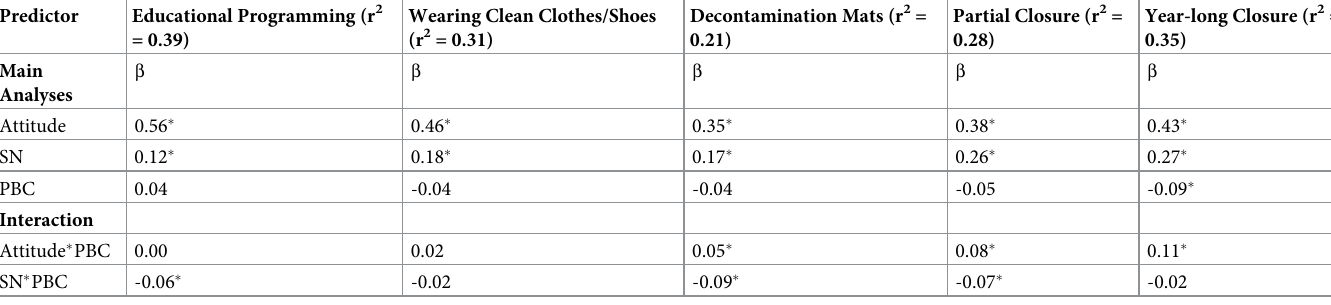
Table 5. Structural equation modeling standardized outputs explaining how likely national park visitors were to participate or comply in white-nose syndrome pre- ventive actions using the three components of the theory of planned behavior (attitudes, subjective norms [SN], perceived behavioral control [PBC]) and two inter- action terms (attitude � PBC; SN �